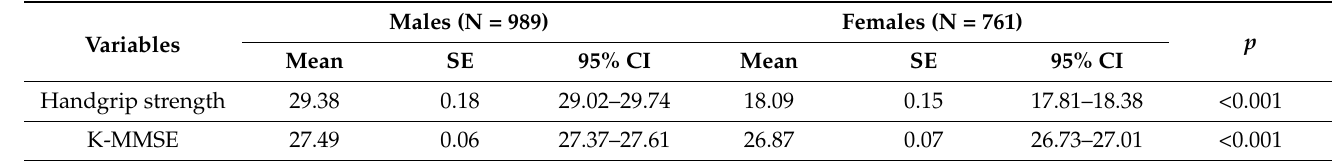
Table 1. Handgrip strength and K-MMSE scores according to sex at baseline.